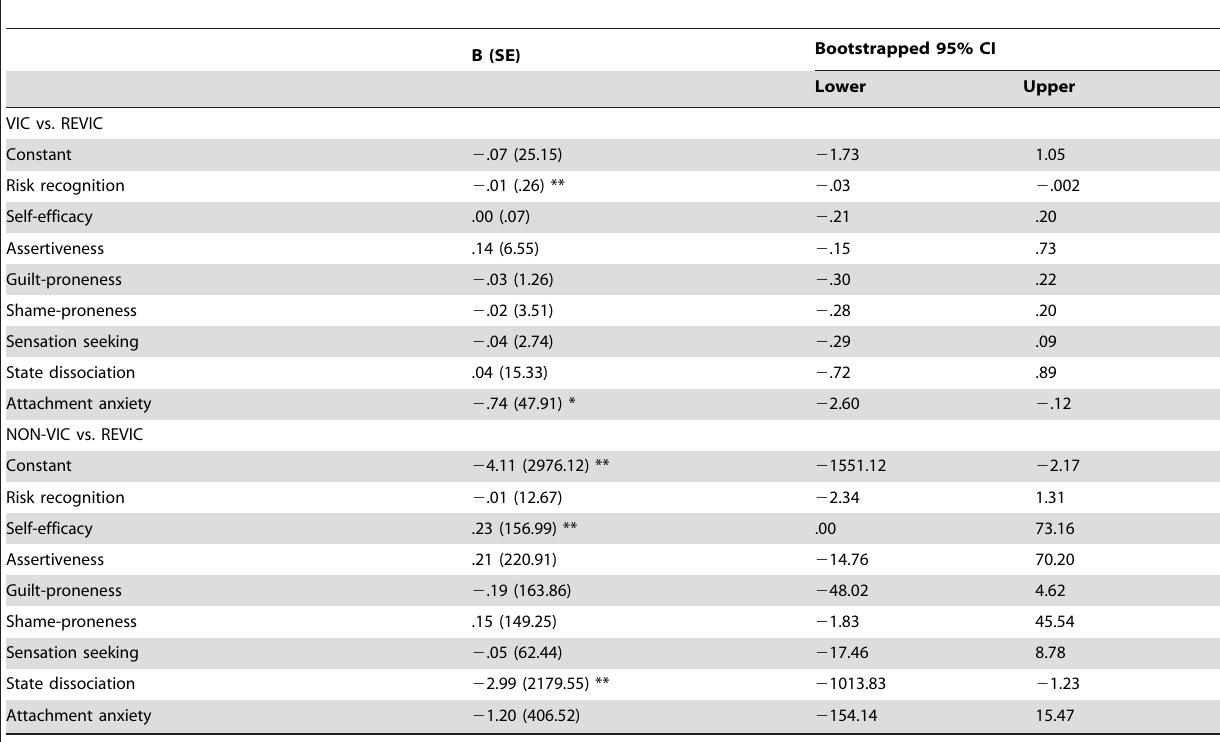
Table 5. Multinominal logistic regression model predicting revictimization.